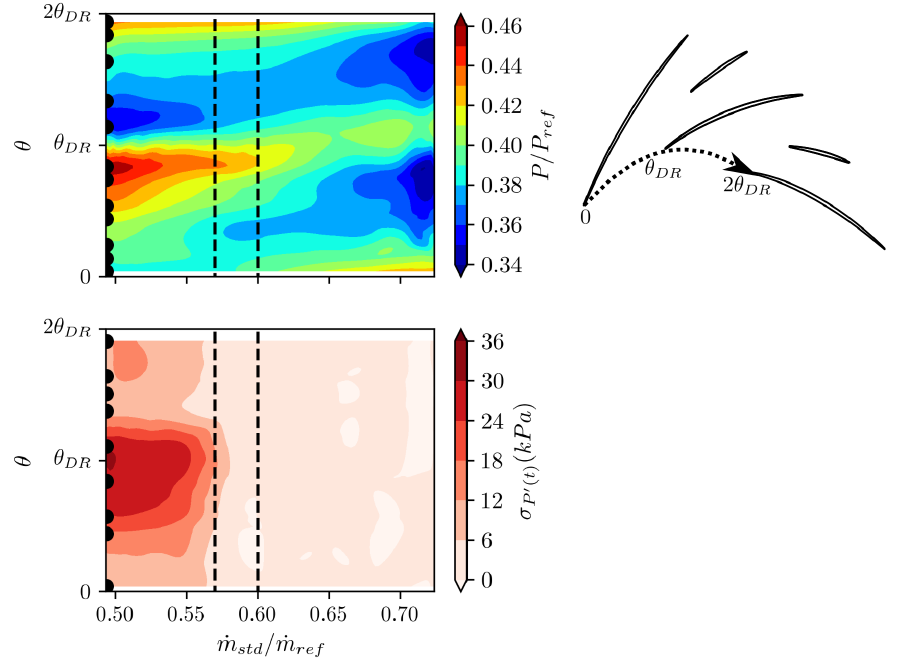
Figure 4. Evolution of the alternate pattern with respect to standard mass flow rate at the radial diffuser inlet and an IGV stagger angle of 0 ◦ : steady static pressure ( top ) and unsteady static pressure standard deviation ( bottom